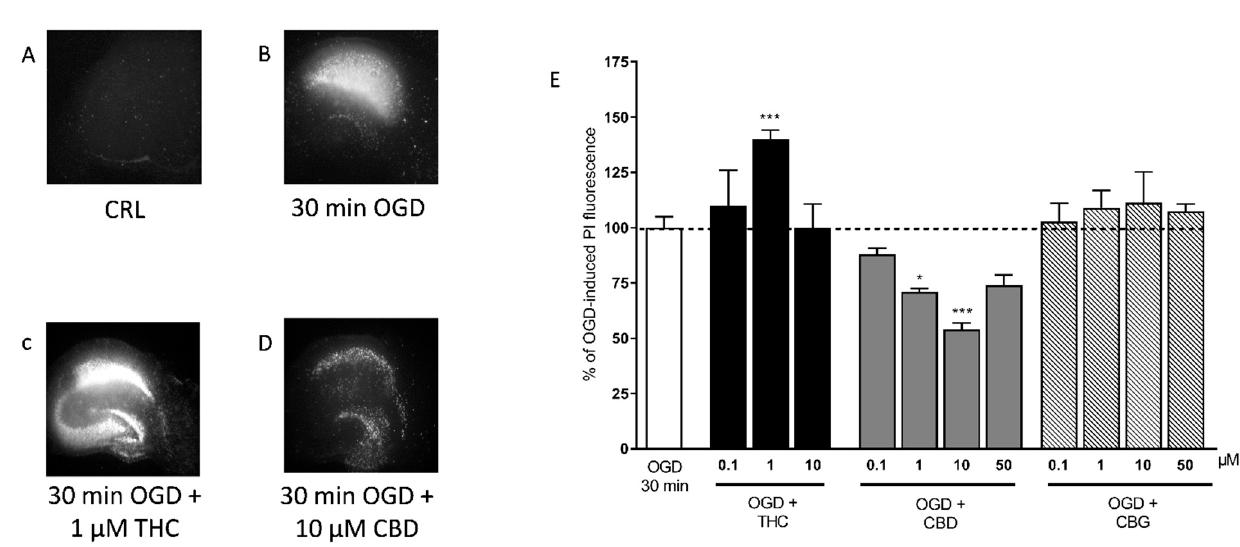
Figure 2. Qualitative and quantitative analysis of the effects of selected cannabinoids in rat organotypic hippocampal slices exposed to OGD. ( A ) Hippocampal slice under normal conditions (background PI fluorescence), slice exposed to 30 min OGD displaying intense PI labeling in the CA1 subregion ( B ), CA1 damage induced by 30 min OGD was exacerbated by the presence of 1 µ M THC ( C ) CA1 damage induced by 30 min OGD was attenuated by the presence of 10 µ M CBD ( D ). ( E ) THC, the psychoactive constituent of Cannabis , significantly exacerbated the neurotoxic effects induced by OGD at the concentration of 1 µ M. CBD significantly attenuated CA1 injury with the maximal effect at 10 µ M, and CBG had no effect. Bars represent the mean ± SEM of at least 5 experiments run in quadruplicate. * p < 0.05 and *** p < 0.001 vs. OGD (one-way ANOVA plus Dunnett’s test).